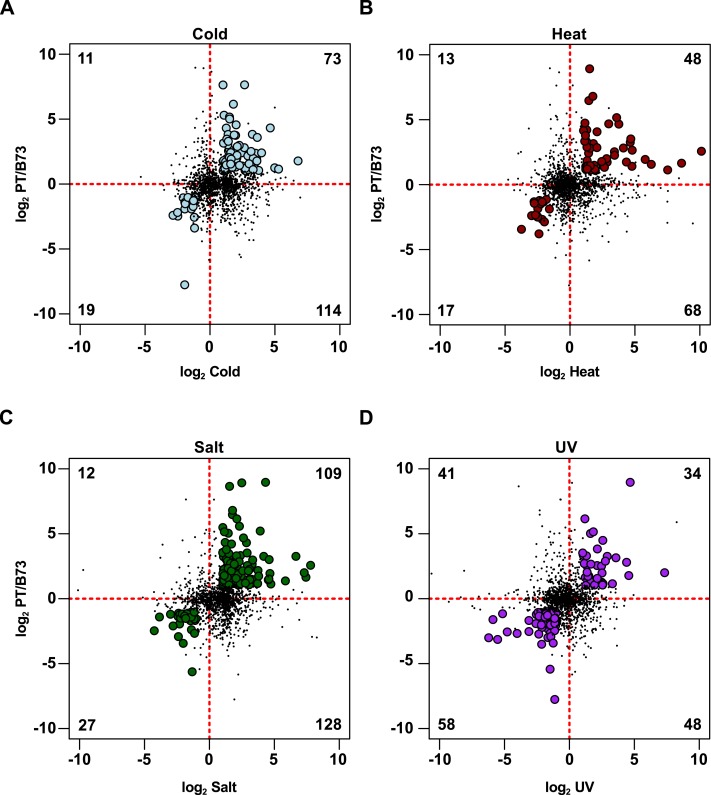
ASE identifies PSR in PT with respect to B73.ASE (log2 PT/B73) in control F1 leaves for the 1,407 sequence variant, stress-responsive gene set against B73 stress response (log2 stress/control) for (A) cold, (B) heat, (C) salt and (D) UV treatments as reported in the Makarevitch dataset. Numbers in each quadrant represent the count of genes called as significant in ASE and stress comparisons. In each plot, the quadrants represent (clockwise from upper left) genes up ASE/down stress, up ASE/up stress, down ASE/up stress, down ASE/down stress. Genes called as up ASE/up stress or down ASE/down stress are considered to show PSR and are shown as filled circles. Other genes are shown as points. Axes through the origin are shown as red dashed lines. A small number of genes outside the axis range are not shown, but are considered in the gene count.